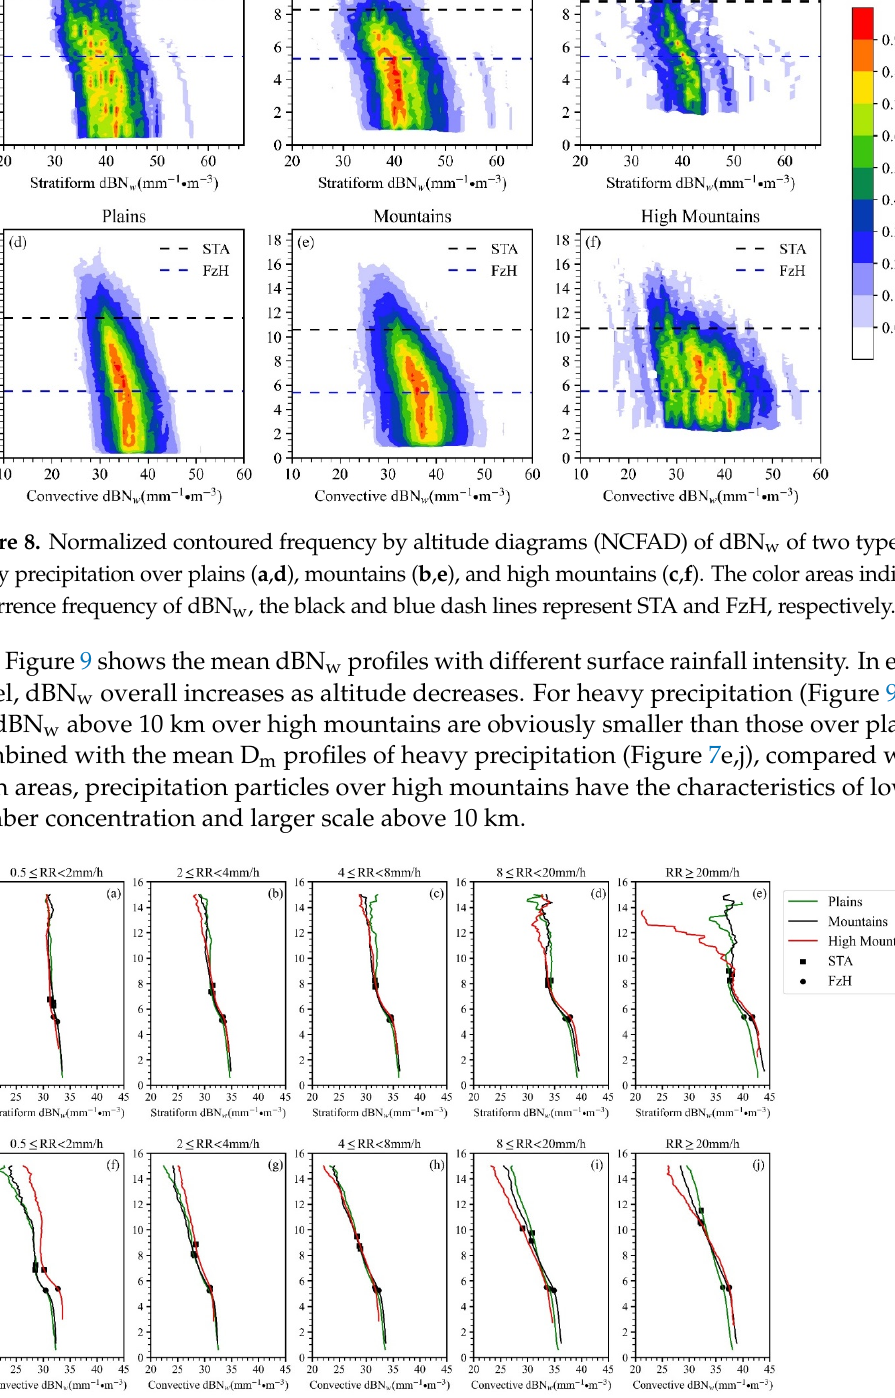
Figure 9. The vertical profile of dBN w with various near-surface RR. ( a – e ) represent SP, ( f – j ) represent CP. The green, black and red solid lines represent plains, mountains and high mountains, respectively. The square and round dots represent STA and FzH, respectively.